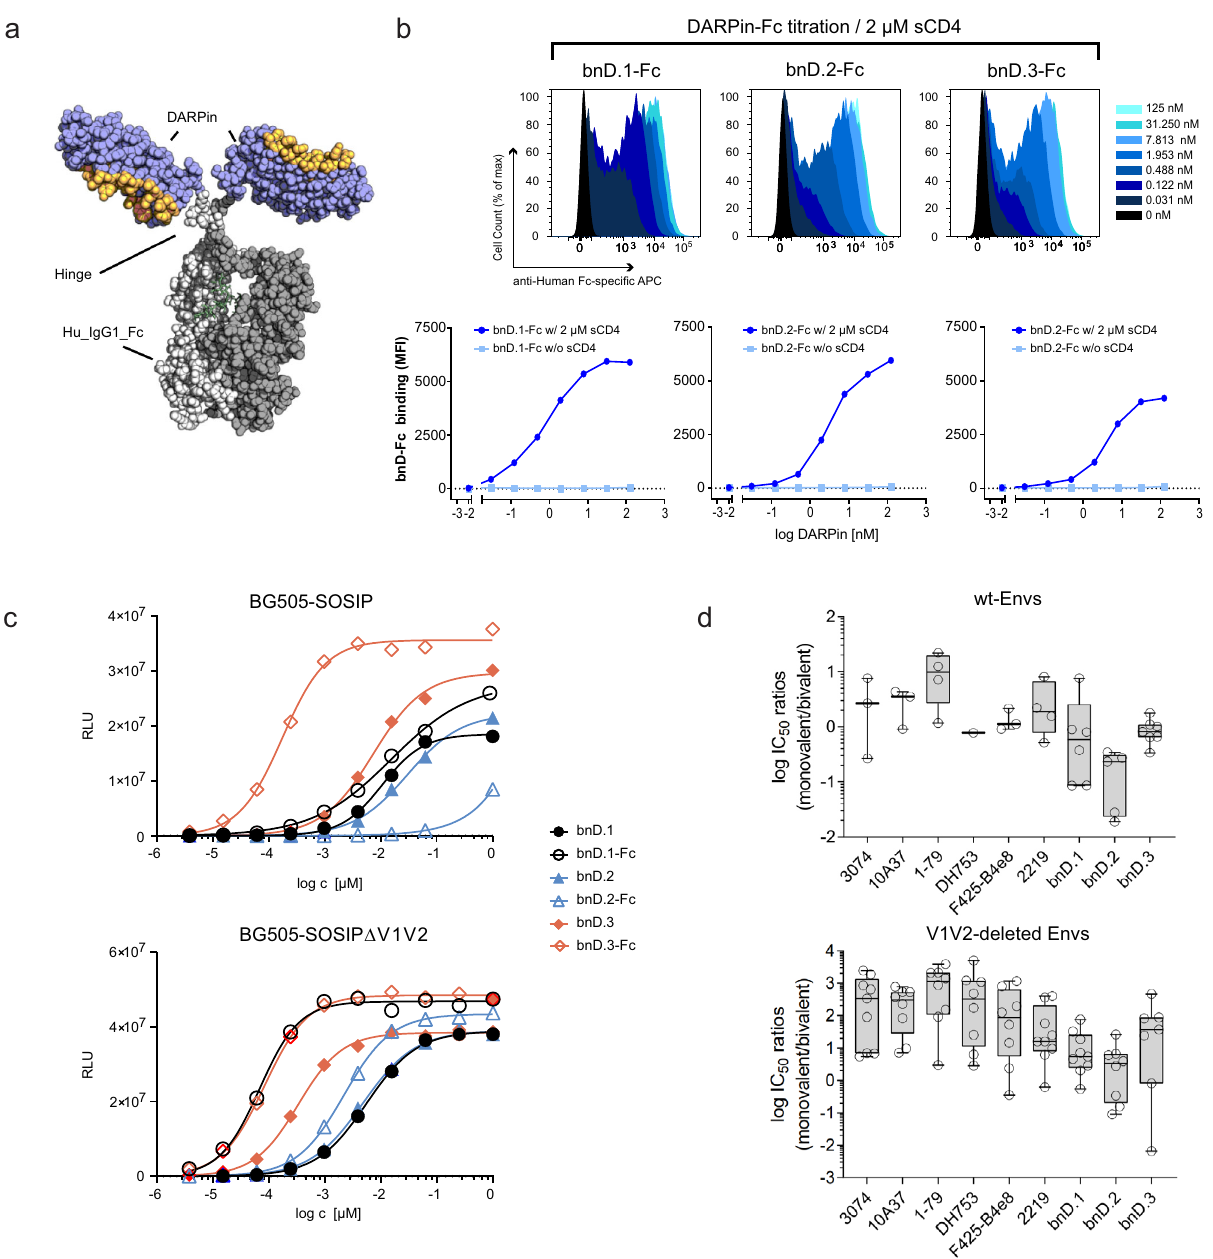
Fig. 5 Activity of bnDs as bivalent molecules. a Model of a bivalent DARPin-Fc generated by fusing the DARPin (violet with orange interaction surface) to the N-terminus of the Fc-region of human IgG1 (light grey and dark grey for the paired chains) with a preserved hinge region. b Binding of bivalent DARPin- Fc fusions to cell surface-expressed Env (JR-FL) measured by fl ow cytometry. DARPins-Fc fusions were titrated and incubated with cells in the presence or absence of 2 µ M sCD4. Mulv Env served as a negative control. Histograms of normalized fl uorescence intensities (top panel) and dose-response curves with mean fl uorescence intensities (MFI, bottom panel) are depicted. See also linked experiments in Supplementary Fig. 12. c Binding of increasing concentrations of monovalent DARPins and bivalent DARPin-Fc fusions to wt (BG505-SOSIP) and V1V2 deleted Env trimer (BG505-SOSIP Δ V1V2) in ELISA. Representative relative luminescent unit (RLU) data from one of two independent experiments are shown. d Comparison of monovalent and bivalent V3 inhibitors. Log IC 50 ratios (Fabs/mAbs and bnDs/Fc-bnDs) from a panel of 9 Tier-2 viruses (top) and corresponding V1V2-deleted viruses (bottom) are depicted. Values > 1 indicate higher potency of the bivalent inhibitor version. Individual data points are shown as circles and were calculated from geometric means of two independent experiments for wt and V1V2-deleted virus respectively ( n = 2). Pairs with resistant strains were not included in the plots. Box plot limits extend from the 25th to 75th percentiles; centerline: median; whiskers indicate the minimum and maximum values. See Supplementary Data 9 and Supplementary Fig. 13 for a full data